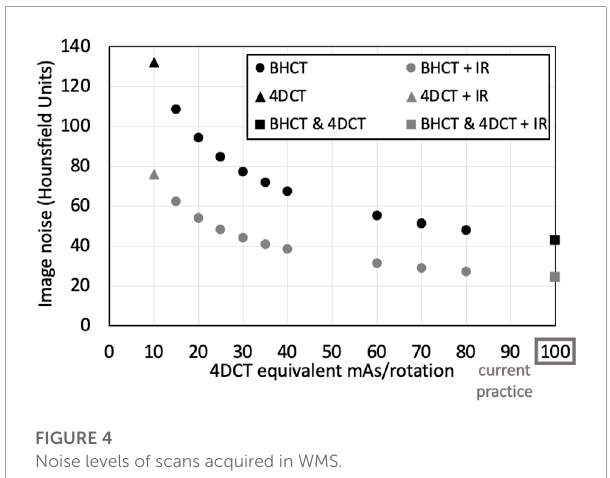
FIGURE 4 Noise levels of scans acquired in WMS.